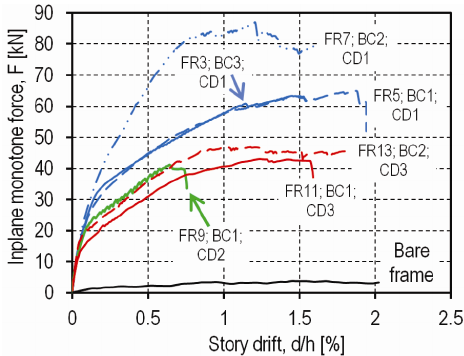
Fig. 3. Responses of specimens FR3, FR5, FR7, FR9, FR11 and FR13 on monotonously applied loading